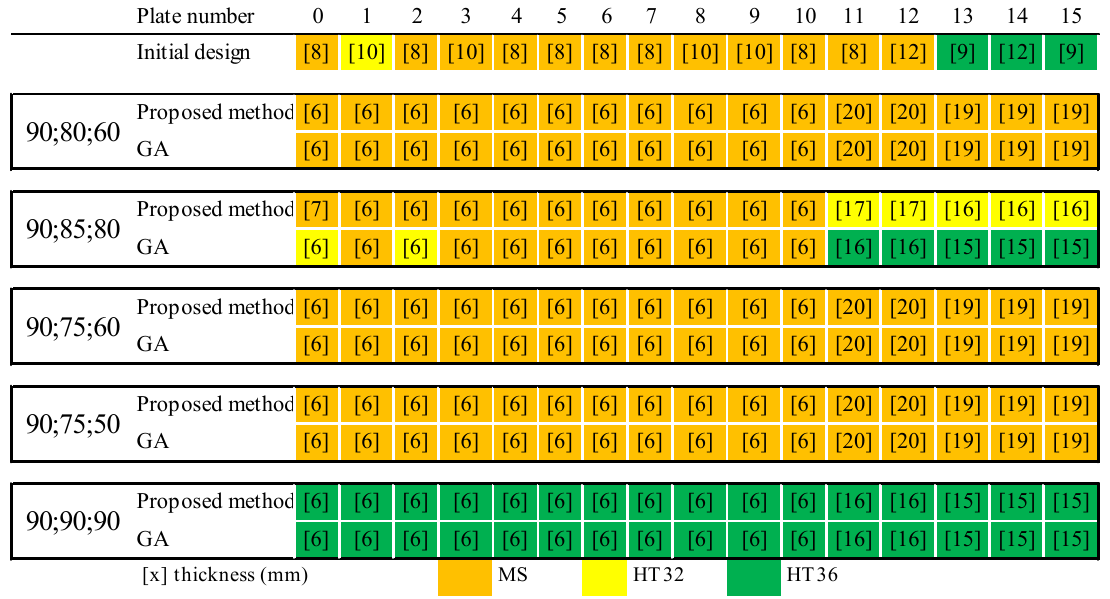
Figure 10. Plate material type and thickness distribution of 1st model.